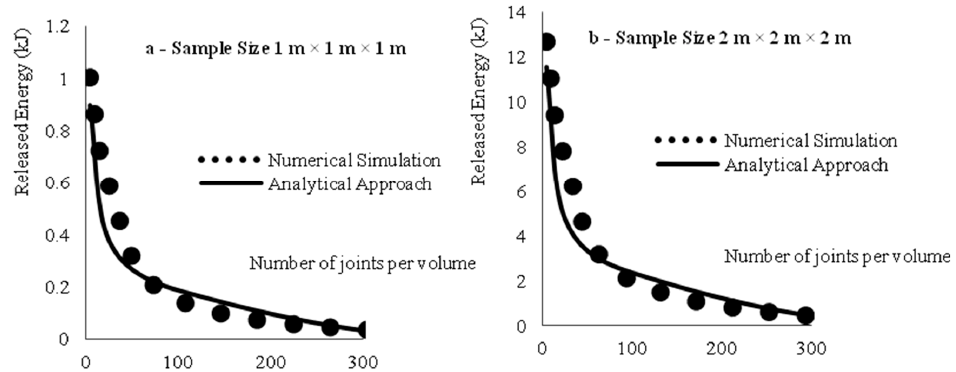
Figure 8. The amount of the released energy in different coal samples due to the different the crossed joint sets